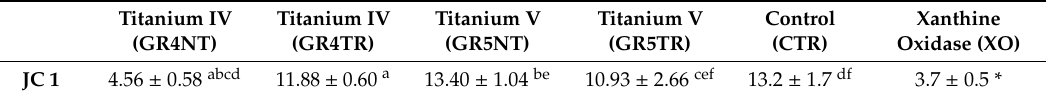
Table 3. Results of the determination of mitochondrial energy balance with JC-1 staining after 24 h of incubation.